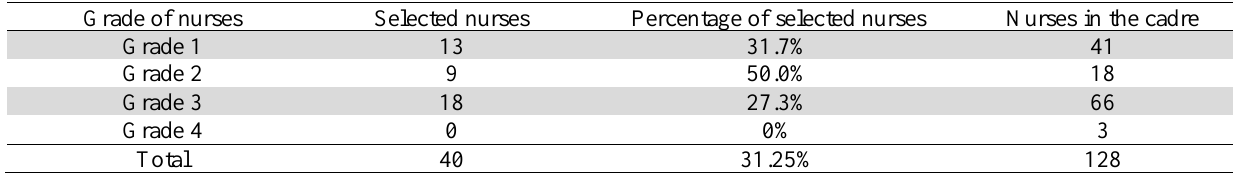
Job rank representation of nurses in the selected sample Grade of